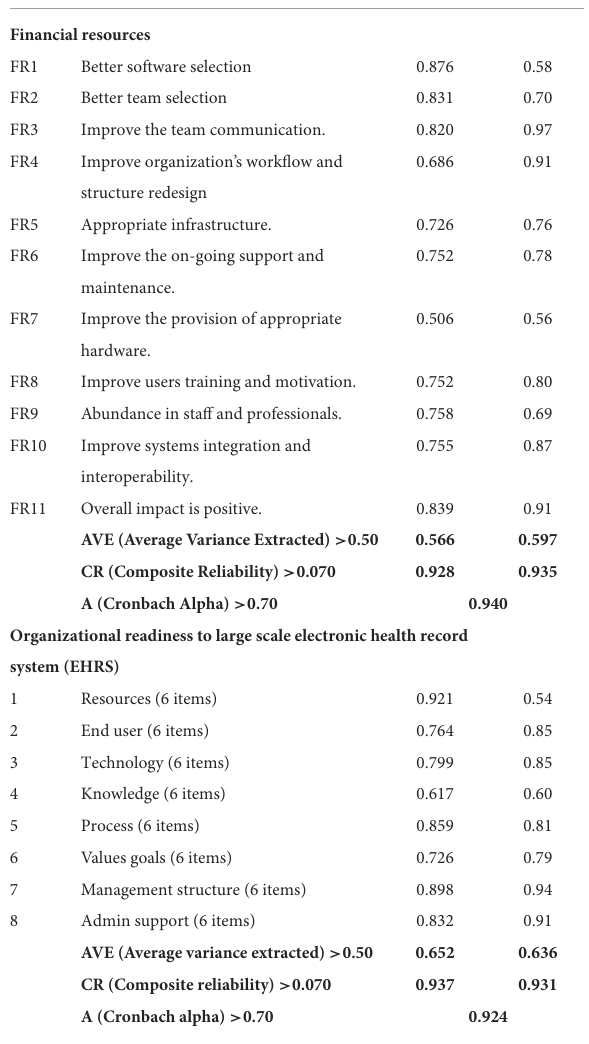
TABLE 3 Measurement model EFA & CFA